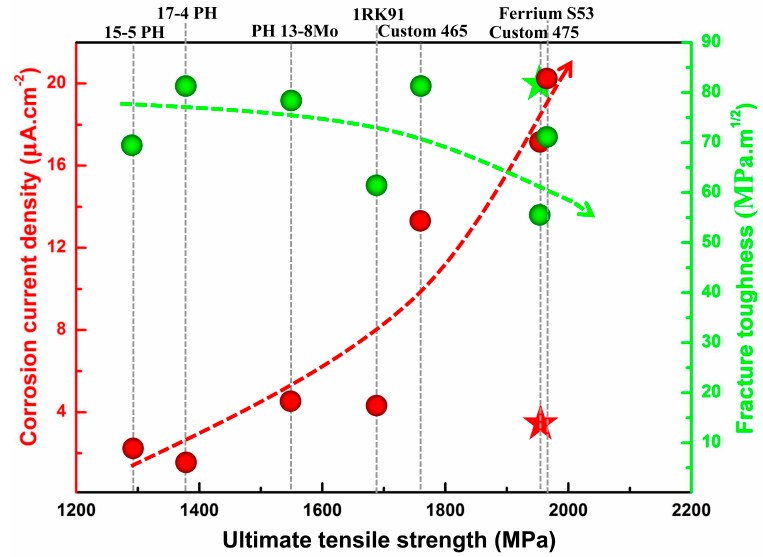
Figure 1. The strength–toughness–corrosion property profiles of the IMR (Institute of Metal Research) steel and comparative maraging stainless steels under peak-aged conditions. Sphere denotes the property of comparative maraging stainless steel and pentacle denotes the property of IMR steel.